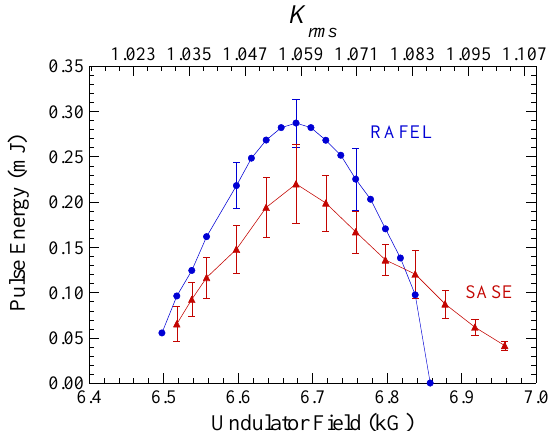
Figure 12. Output pulse energy for the IR RAFEL (blue circles) and an equivalent SASE FEL (red triangles) as a function of the undulator field strength B u . The cavity detuning for the IR RAFEL is ∆ L cav = − 8 λ , while the other simulation parameters are given in Table 1. The error bars indicate energy fluctuations due to limit-cycle-like oscillations for the RAFEL and pulse-to-pulse rms energy fluctuations in case of